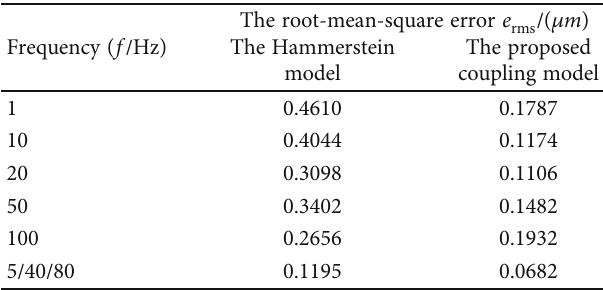
Table 2: The root mean square error of the Hammerstein model and the proposed coupling model.